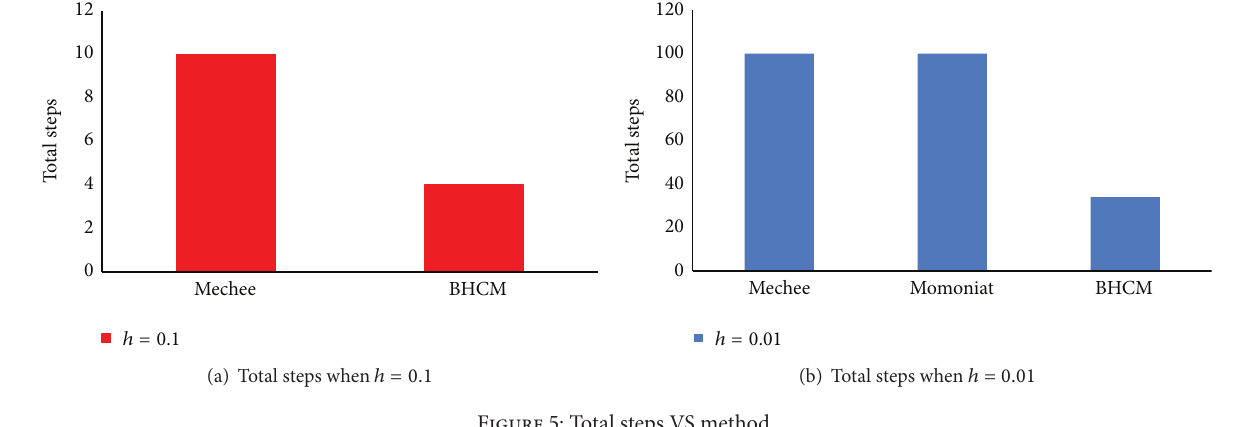
Figure 4: Plot of solutions for nonlinear Genesio equation.